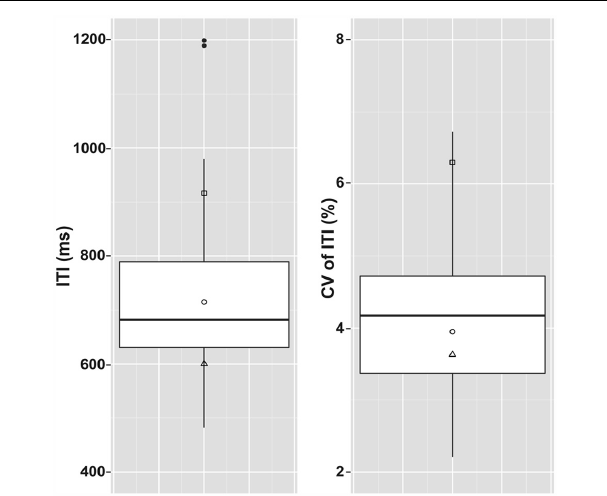
FIGURE 2 | Inter-tap-intervals (ITIs) and coefficient of variation of ITIs in the three dysrhythmic participants compared to the control group for the spontaneous tapping task. Boxes summarize the control group data. Top and bottom edges of the boxes give 1st and 3rd quartiles and the middle bands give the group medians. Whiskers include data that is within 1.5 interquartile ranges of the 1st and 3rd quartiles and filled circles represent control data outside of this range. Left panel gives raw ITI values and right panel gives standard deviations of ITI as a percentage of mean spontaneous tapping rate. (cid:3) = SS; ◦ = SWI; (cid:4) = VPO. Filled circles represent outlying control